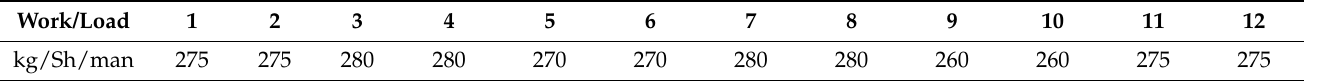
Table 4. Iron works of ceiling structure—performance